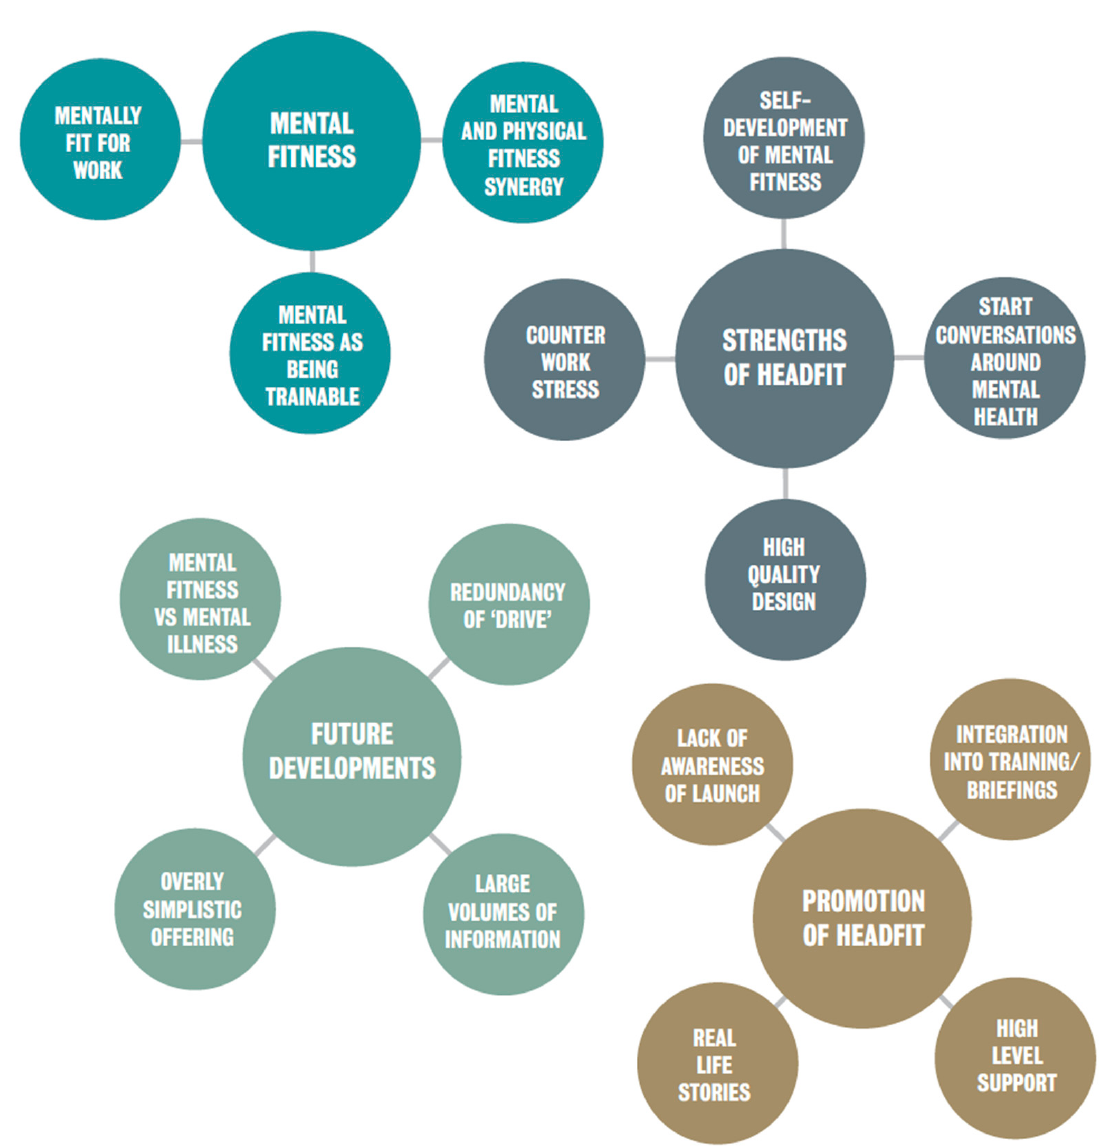
Figure 4. Themes and sub-themes from beneficiary